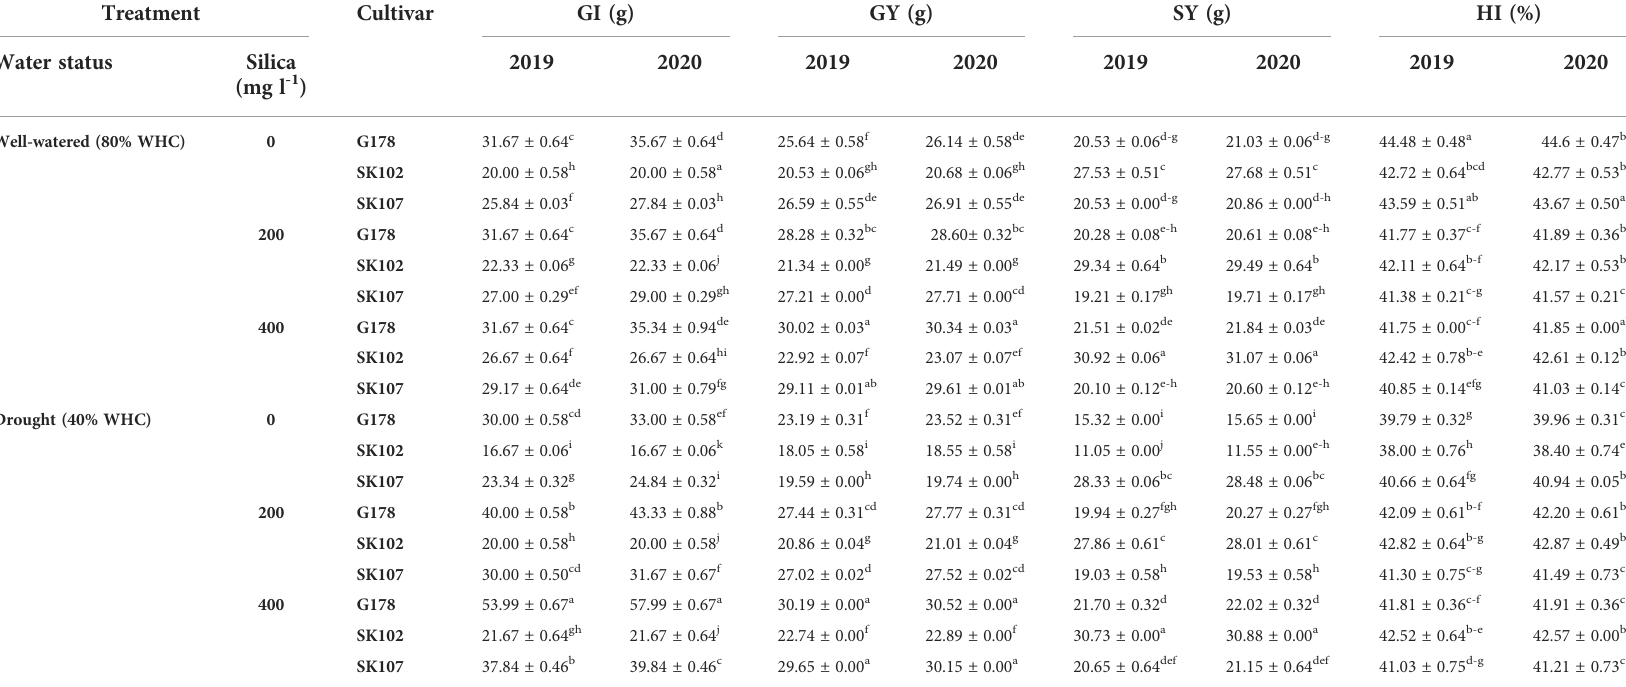
TABLE 3 Effects of foliar application of silica on the yield in response to drought stress during the growing seasons of 2019 and